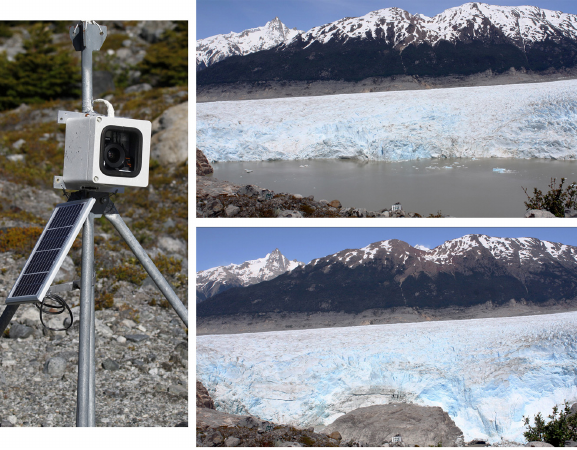
Figure 2. Measurement images: filled lake (top), empty lake after GLOF event